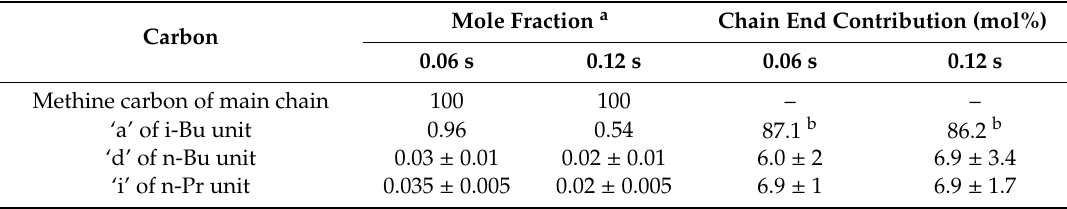
Table 1. 13 C NMR chain end analysis of PP obtained from LSF propylene